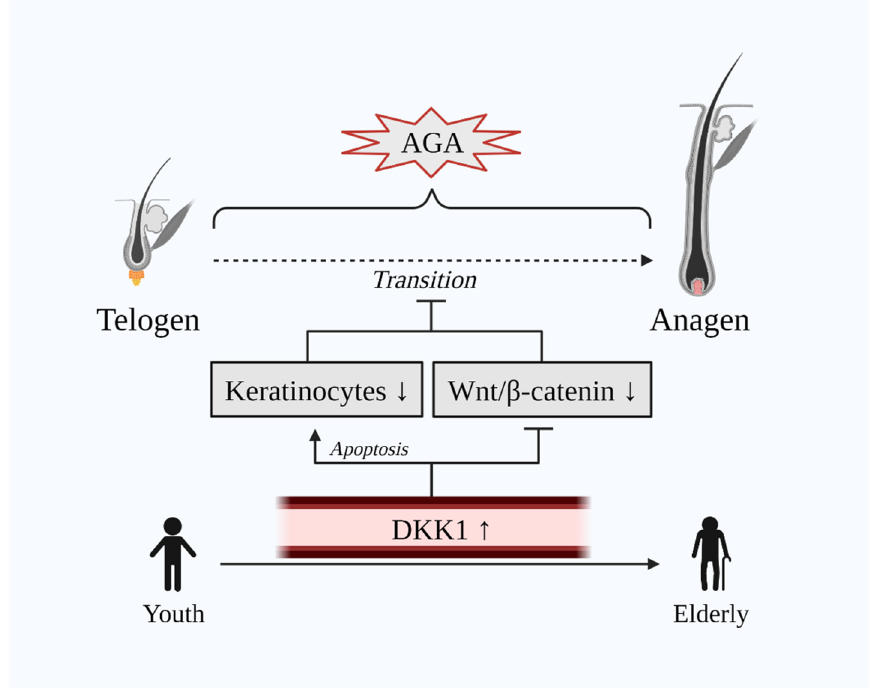
Figure 2. Dual unfavorable role of DKK1 on hair growth. The transition of telogen to anagen is delayed in AGA. DKK1 is upregulated in the scalp of AGA as well as in the serum of the elderly population where AGA is common. Elevated DKK1 levels induce the apoptosis of keratinocytes and inhibit Wnt/ β -catenin signaling. Abbreviations: AGA, androgenetic alopecia; DKK1, dickkopf-related protein 1; Wnt, wingless and integrated-1.